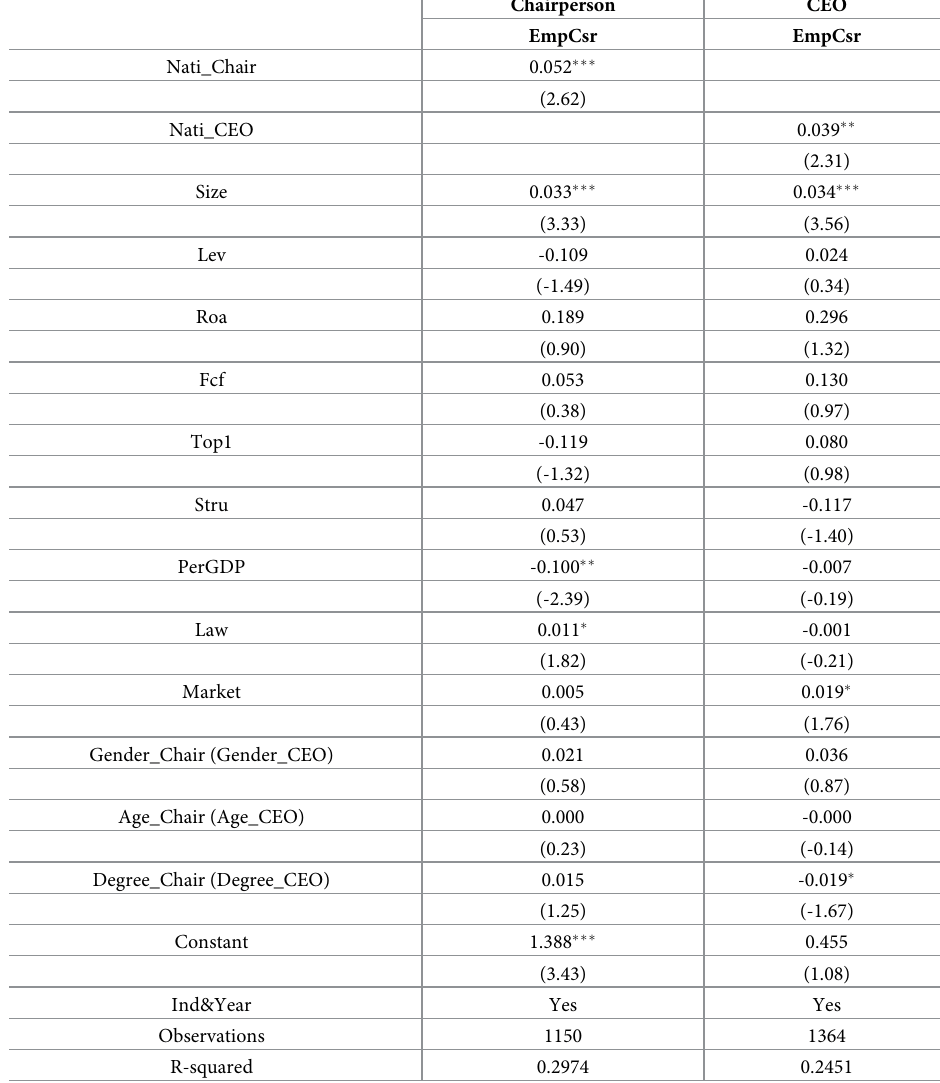
Table 5. OLS regression based on propensity score